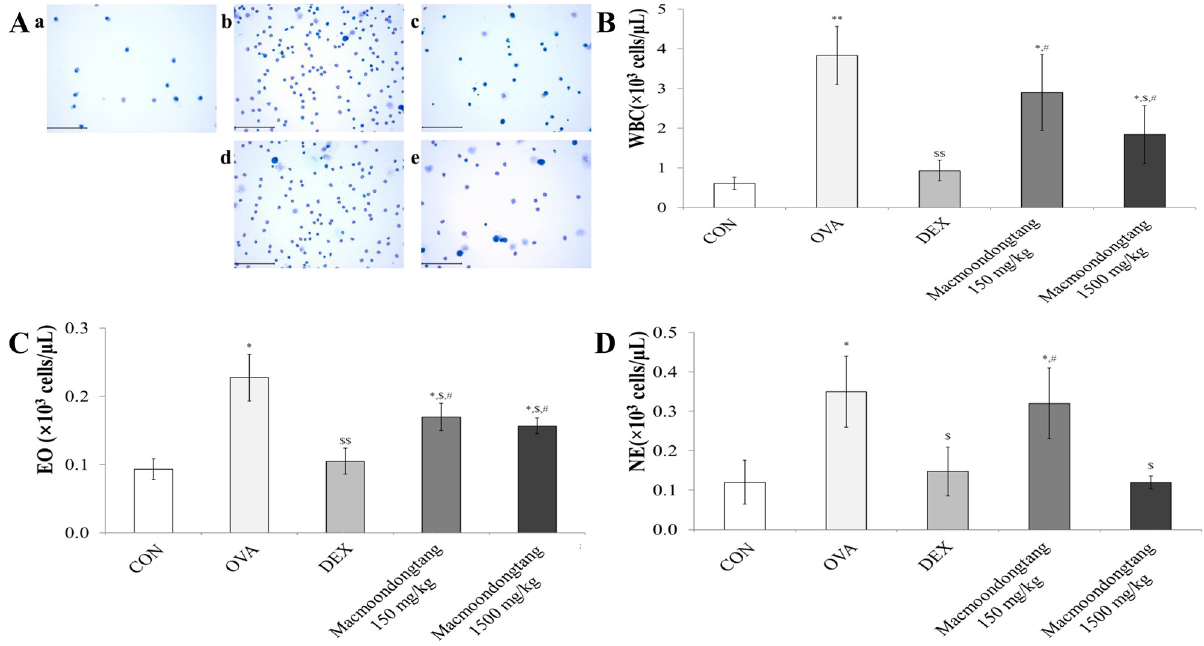
Fig 2. Macmoondongtang treatment suppressed infiltration of both inflammatory cells and immune cells such as white blood cells (WBCs), eosinophils, and neutrophils. (A) Macmoondongtang effectively decreased OVA-induced proliferation of inflammatory cells. (B) Macmoondongtang dose- dependently down-regulated the population of WBCs. (C) Macmoondongtang effectively suppressed the number of eosinophils. (D) Macmoondongtang significantly and dose-dependently decreased neutrophil proliferation. a ,vehicle control; b ,asthma induction; c ,dexamethasone; d ,150 mg/kg/day macmoondongtang ; e ,1500 mg/kg/day macmoondongtang .Each bar represents the mean ± SD (n = 8). � p < 0.05 vs. control; �� p < 0.001 vs. control; $ p < 0.05 vs. asthma induction; $$ p < 0.01 vs. asthma induction; # p < 0.05 vs. dexamethasone. Scale Bar = 100 μ m.Magnification, × 400.